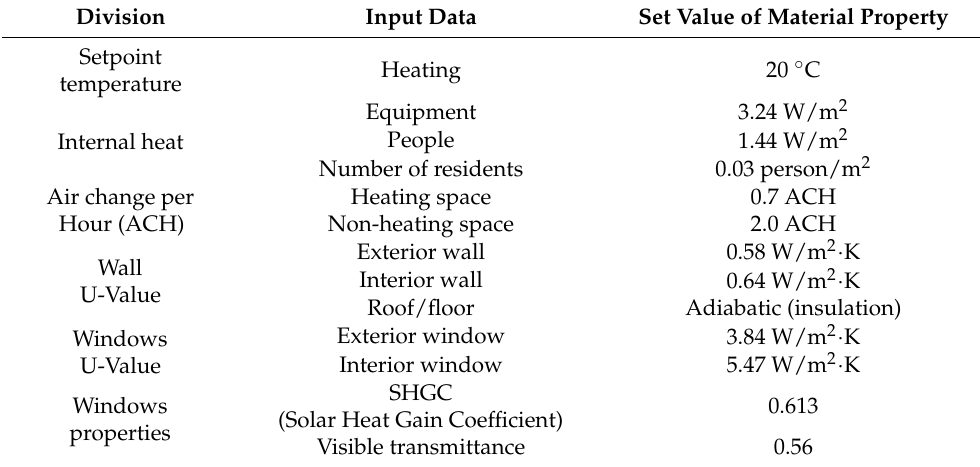
Table 2. Set up value of material property for envelope composition of apartment houses subjected to